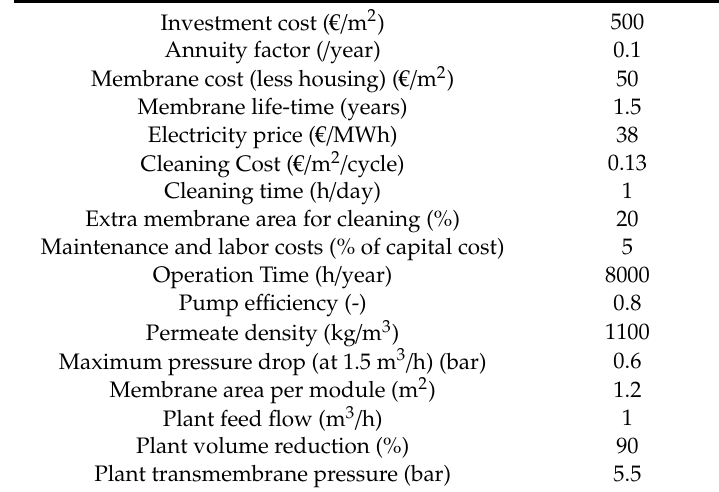
Table 2. Assumptions for the cost estimates (Based on Spiral module (2517) with 48 mil spacer by Alfa